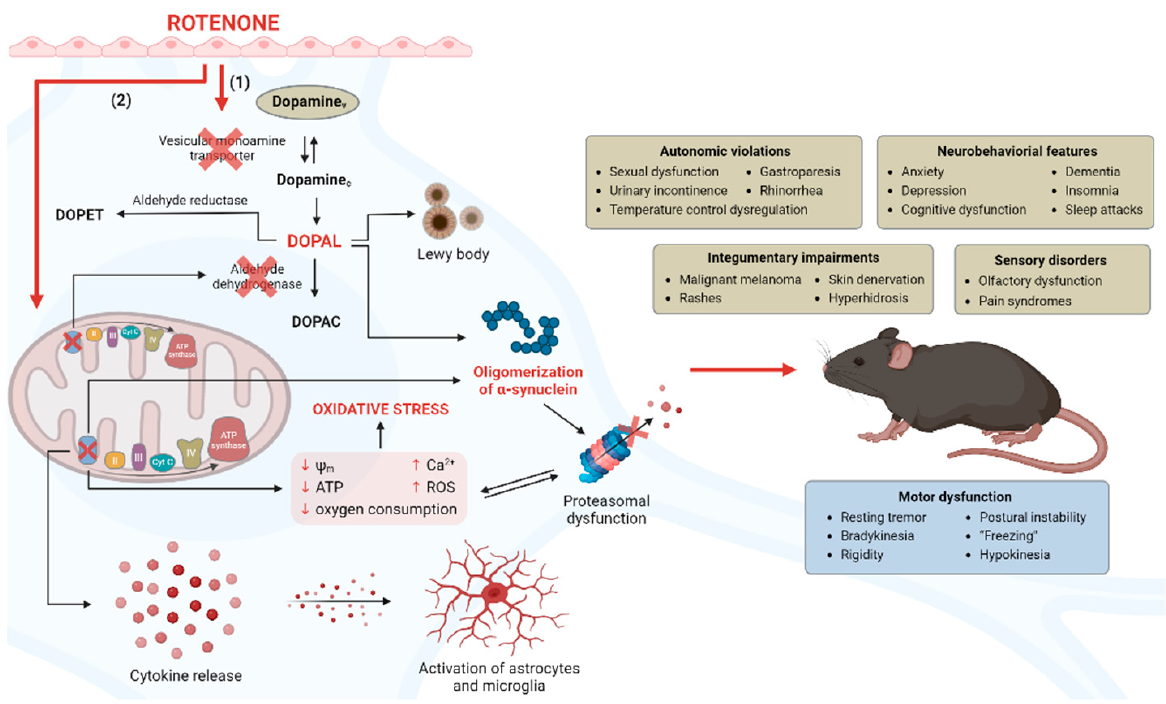
Figure 2. The proposed mechanism of rotenone action in the parkinsonism progression. Within the neuron, dopamine exists in two forms: vesicular (Dopamine v ) and cytoplasmic (Dopamine c ),